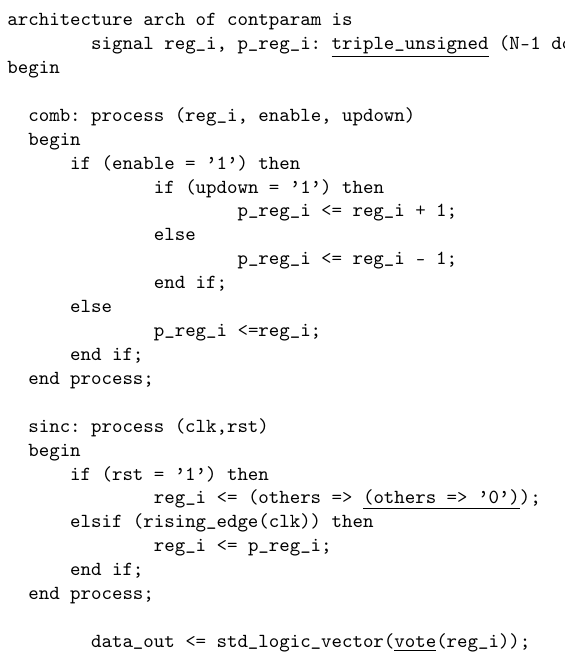
Figure 5. Hardened 2-to-1 multiplexer. Note that the equality comparison operator is overloaded, so sel can be compared to ’0’ .